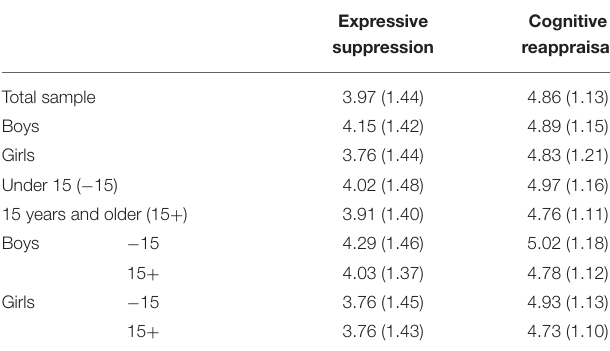
TABLE 4 | Test-retest reliability and criterion validity of the ERQ scales. TABLE 5 | Means and standard deviations of the two emotion regulation strategies for the total sample and by gender and age.